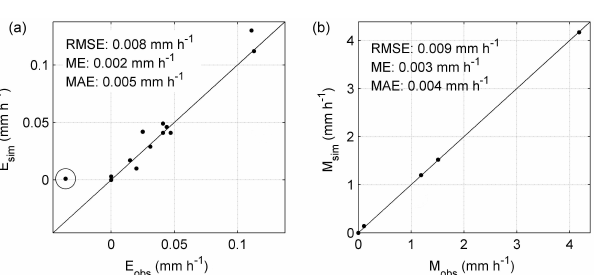
Figure 3. Measurements versus model estimates of evaposublima- tion ( E ) and melting ( M ) for the different test periods using the cal- ibrated values for each test in Table 4. Each plot includes the root mean square error (RMSE), the mean error (ME), and the mean ab- solute error (MAE). The line indicates a 1:1 relationship between observed (obs) and simulated values